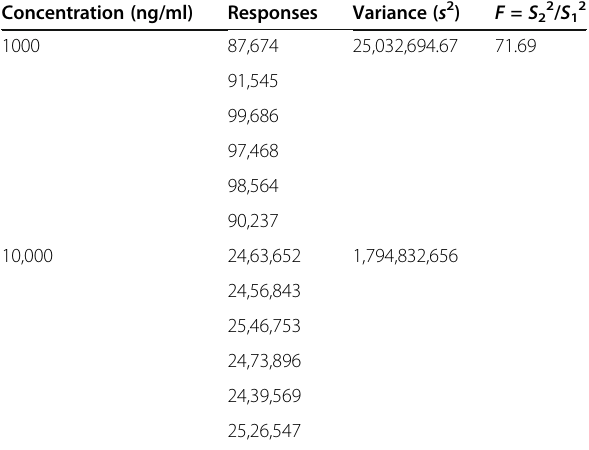
Table 3 Test for homogeneity of variance, F test Concentration (ng/ml) Responses